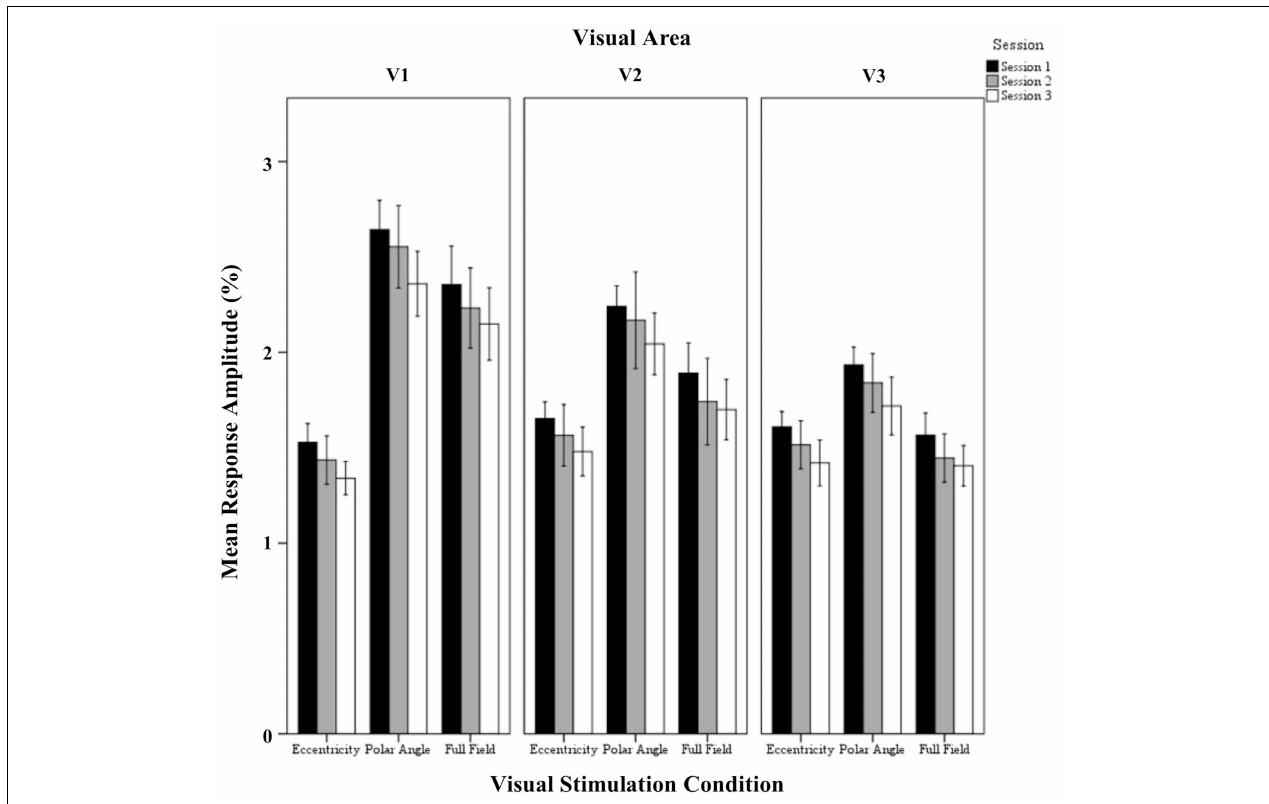
FIGURE 3 | Quantitative comparison of response amplitude (mean ± SEM) across sessions in V1, V2, and V3 for all visual stimulation conditions. Significant effects were observed for the factors session, stimulation condition, and visual area, and for the interaction of visual stimulation condition and visual area as detailed in